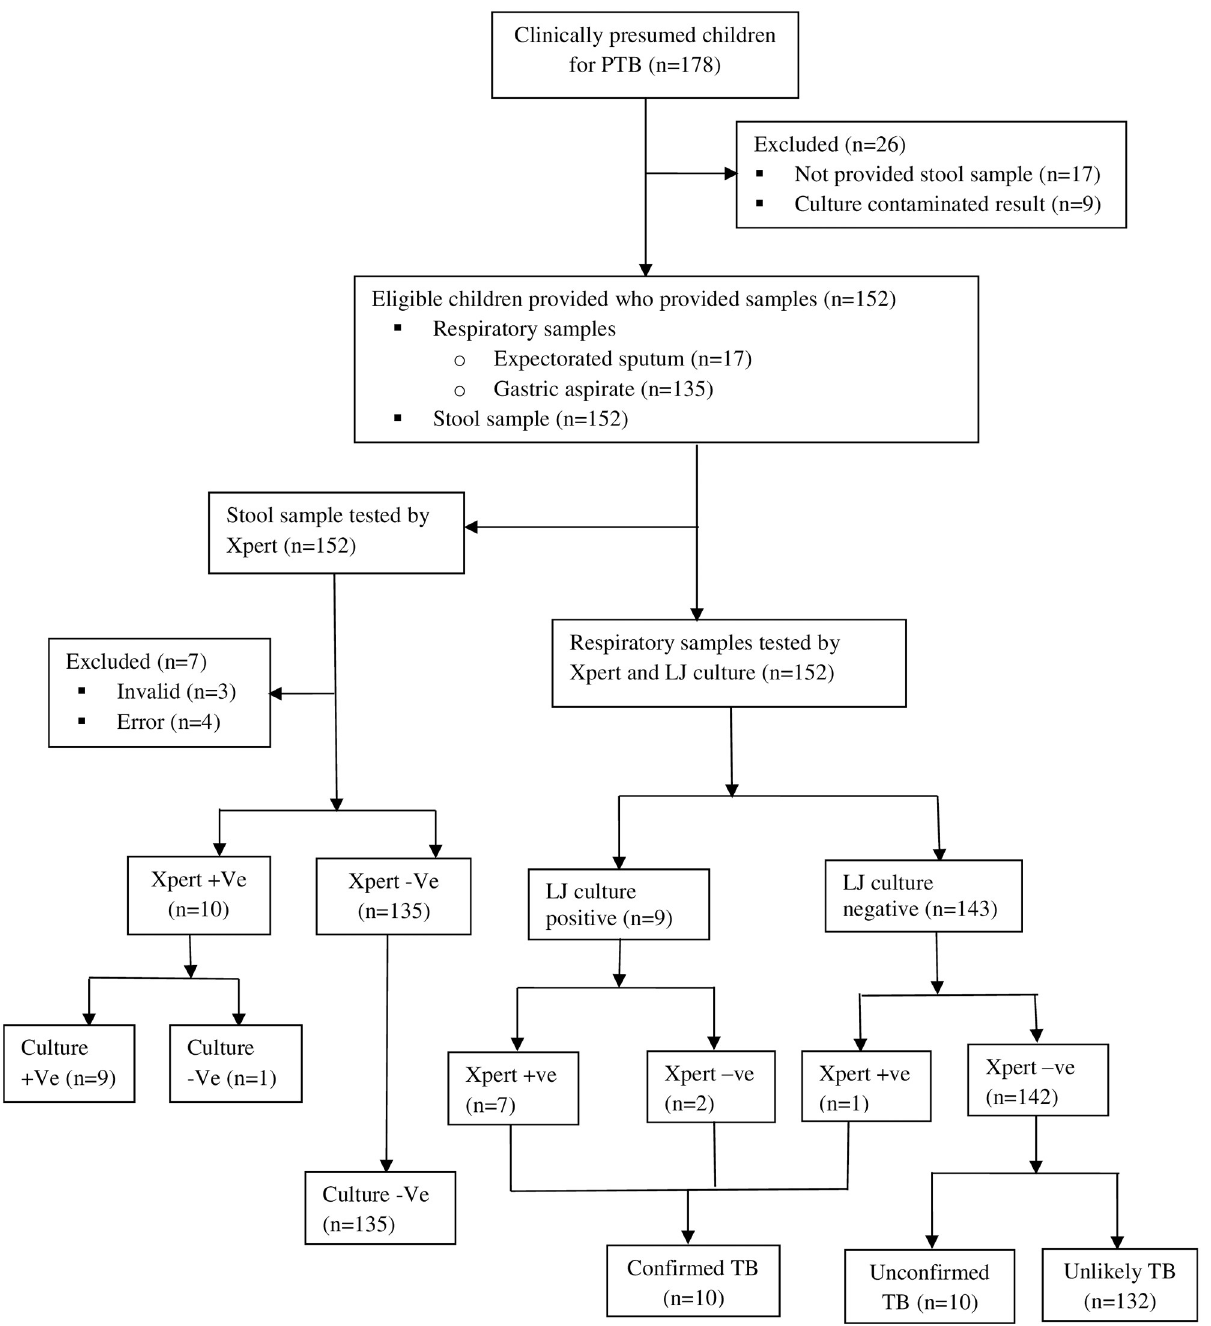
Fig 1. Flow chart describing study workflow and diagnostic classifications. TB = tuberculosis, PTB = pulmonary tuberculosis, n = number, +Ve = positive, -Ve = negative, LJ = Lowenstein-Jensen.